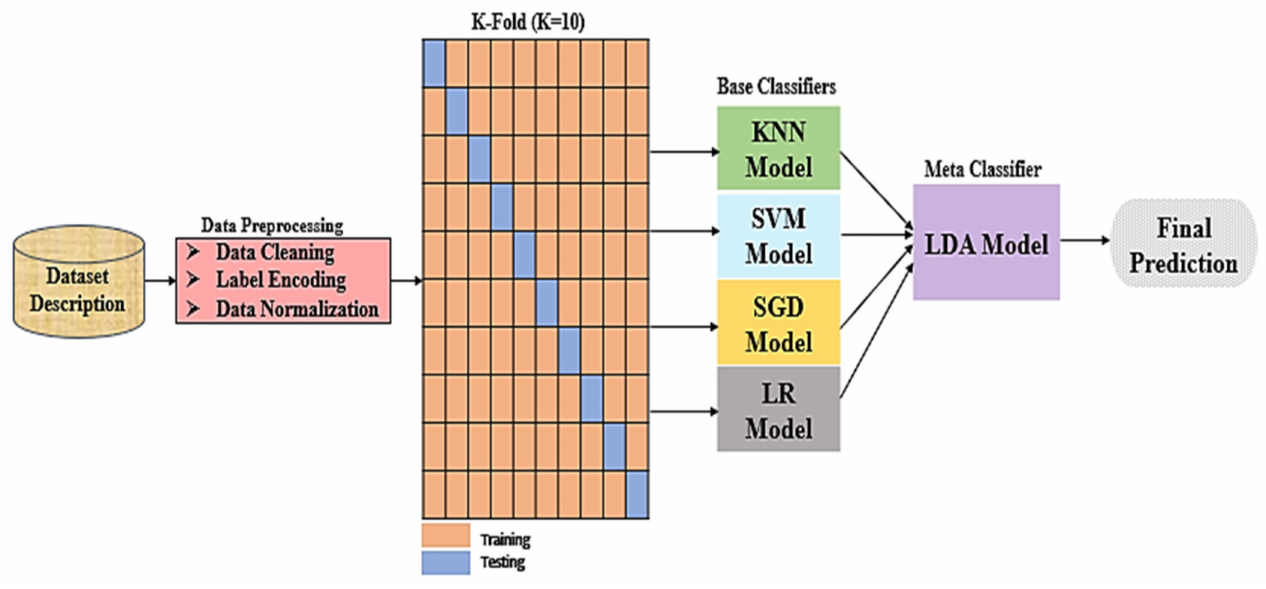
Figure 1. The stages for the proposed stacked